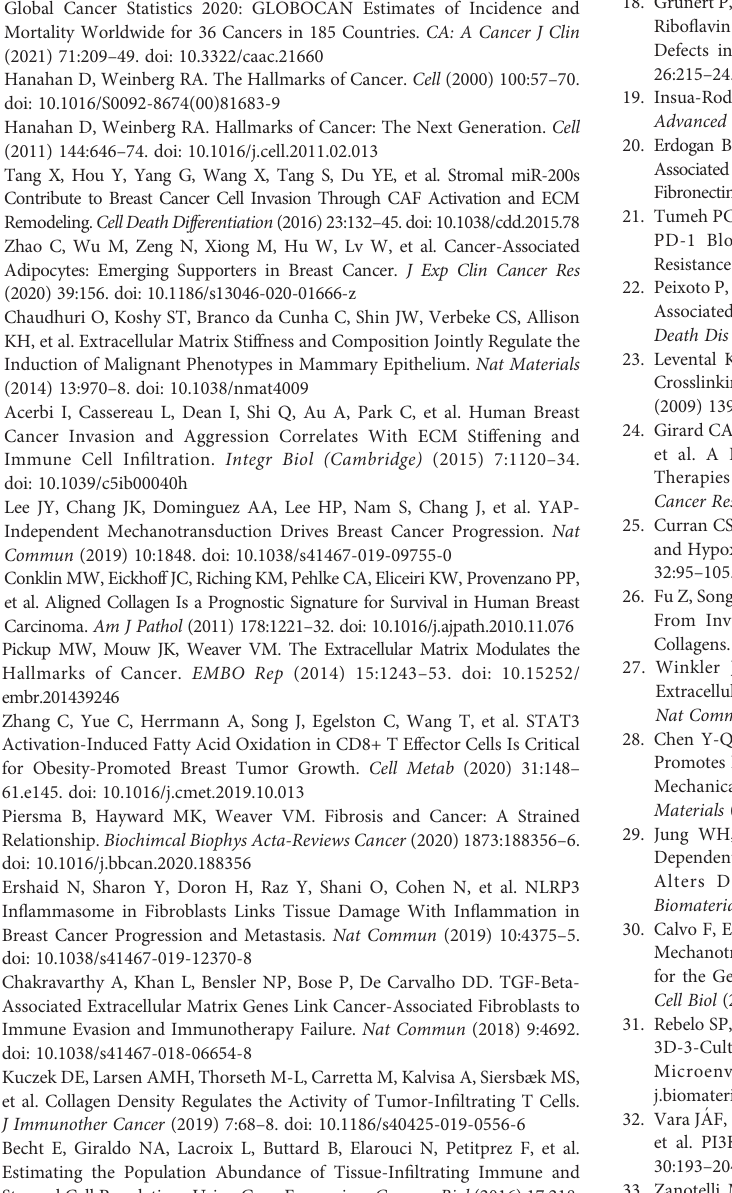
Supplementary Figure 3 | Aligned collagen matrix enhances CAF induction of NIH/3T-3 cells A. Random and aligned collagen fi brils models conducted by magnetic stretching. B. IL-2 levels of primary T cells and Jurkat T cells in un-